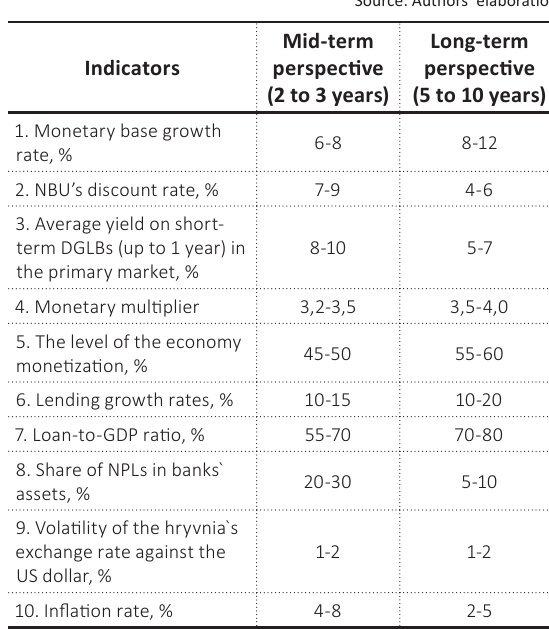
Table 1. Forecast parameters of monetary indicators to improve the efficiency of MTM channels in